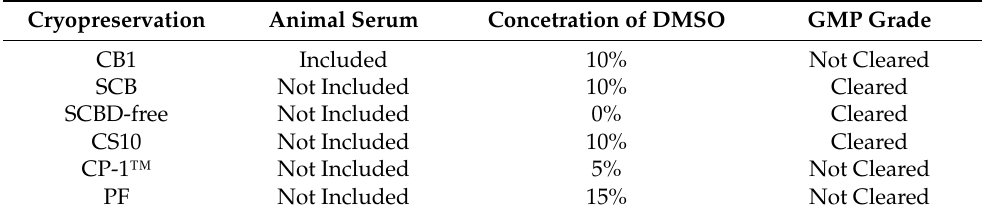
Table 2. Details of cryopreservation solutions. Whether include the animal serum, clears GMP grade, and concentration of DMSO are listed for each cryopreservation. CB-1: CELLBANKER 1, SCB: STEM-CELLBANKER GMP grade, SCBD-free: STEM-CELLBANKER DMSO Free GMP grade, CS10: CryoStor ® CS10, and PF: Pro